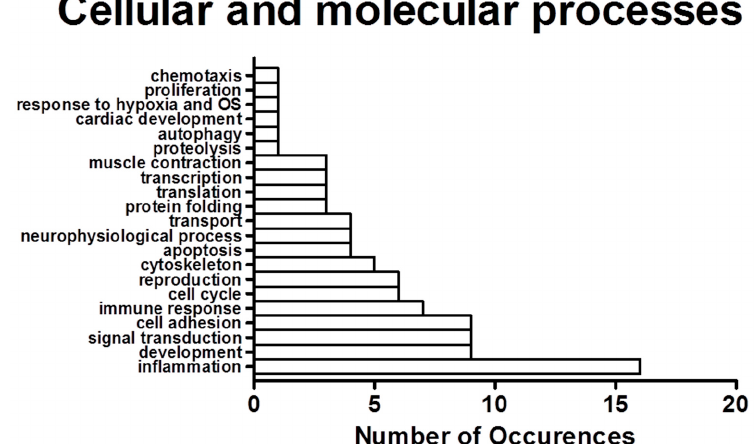
Figure 2. Number of occurrences in the top 100 specific process networks containing dysregulated CBA/SIV+ genes. The processes were classified using MetaCore nomenclature (e.g., the processes “inflammation complement system” and “inflammation IFN ‐ gamma signaling” both count towards inflammation). The top 100 process networks containing differentially expressed genes were included in analysis. OS: oxidative stress; IFN: interferon.